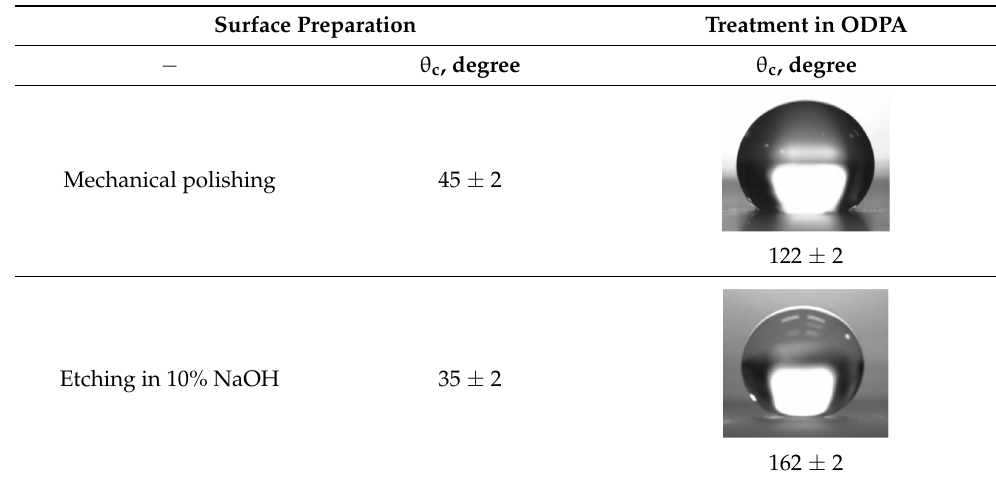
Table 2. Change in the contact angle θ c on alloy 6063 from preliminary surface preparation and then after its modification with an ethanol solution of ODPA C = 1 mmol · L − 1 . Surface Preparation Treatment in ODPA − θ c , degree θ c , degree